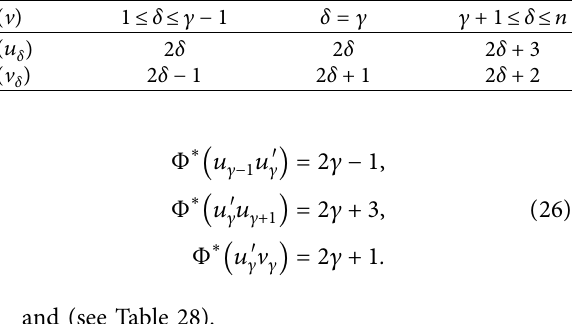
Table 27: Vertex labeling of Φ ( v